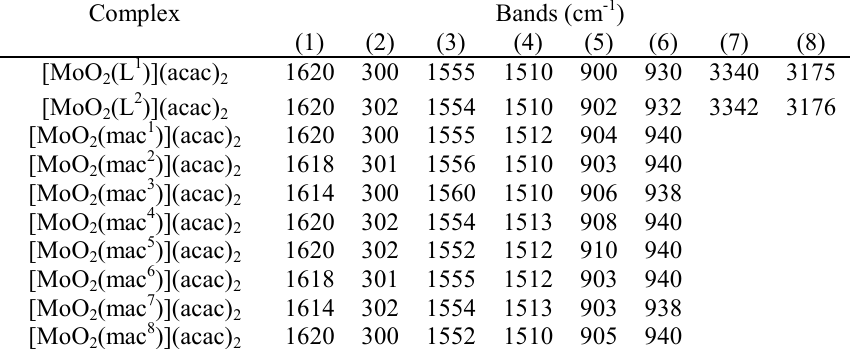
Table 2. Infrared spectral bands of